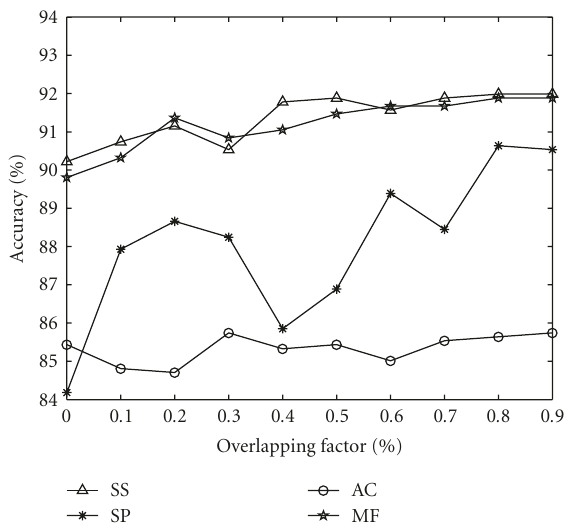
Figure 13: Operation point (5 seconds, 60% overlap) performance, Accuracy 2